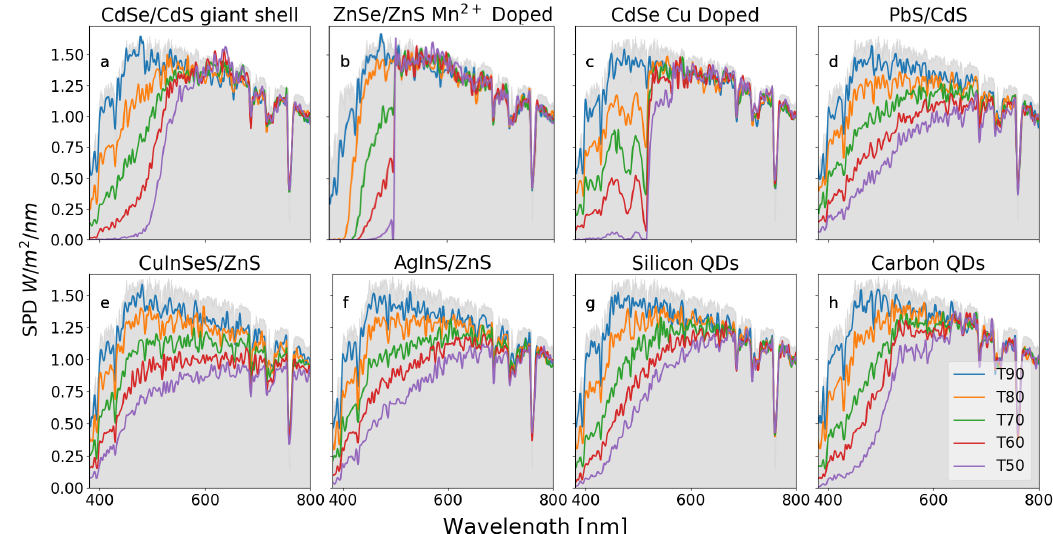
Figure 7. Simulated spectral power distribution of transmitted irradiance for eight different luminophores with five different optical transmittance values. T90 represents a transmittance of 90%, while T50 represents a transmittance of